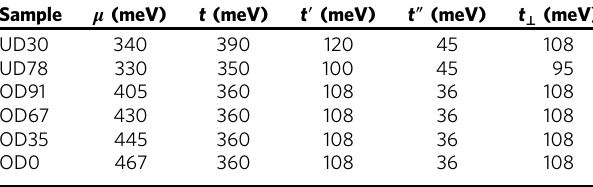
Table 1 Tight binding parameters for Bi 2 Sr 2 CaCu 2 O 8 +